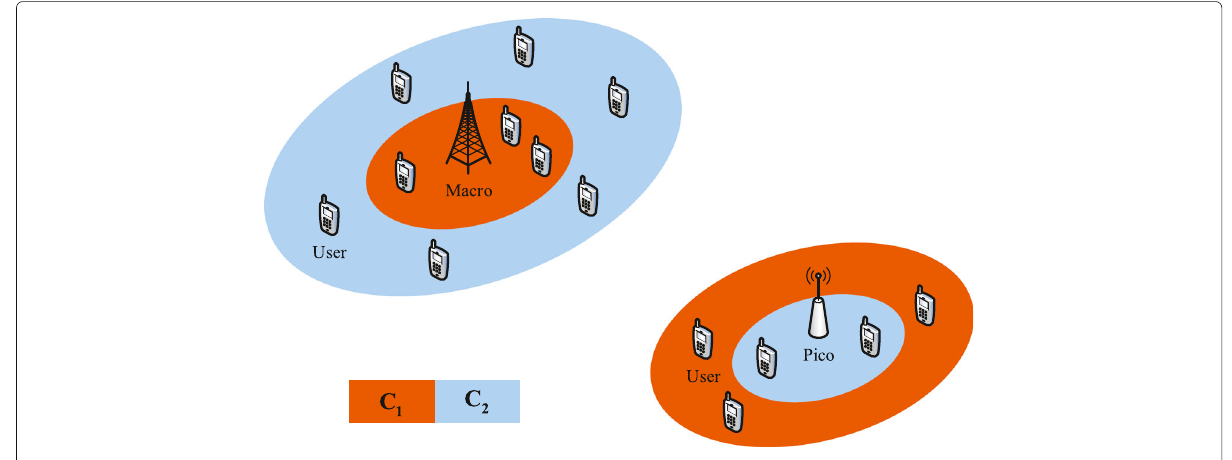
Fig. 1 Illustration of SFR